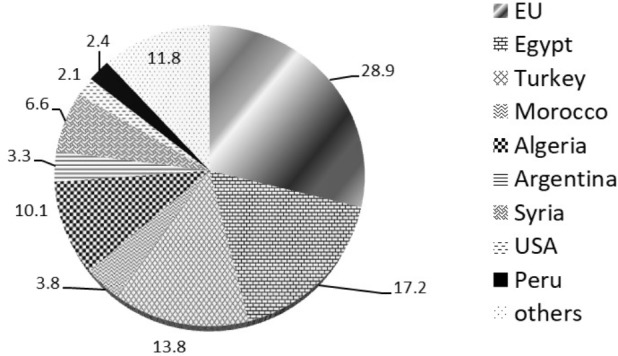
Global prediction for table olive production (in percentage of the overall predicted production of 2.8 million tons for season 2017/2018) by countries. Source: International Olive Council [IOC], 2017.